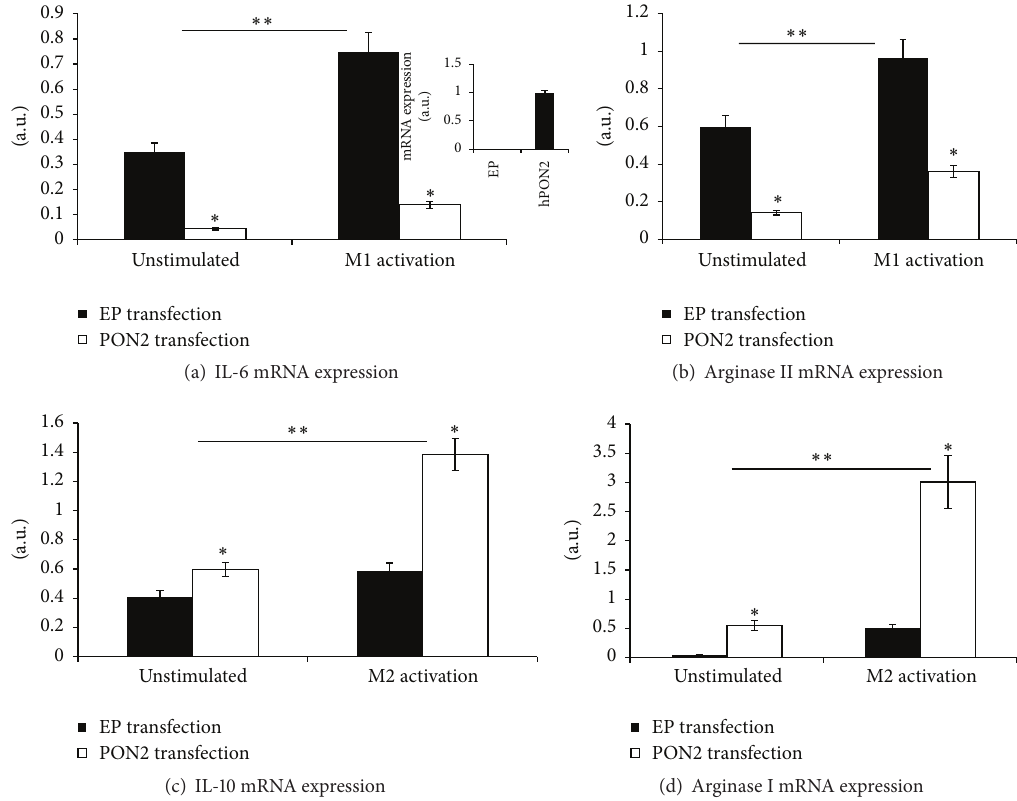
Figure 4: Direct effect of human PON2 (hPON2) on the inflammatory and anti-inflammatory responses in PON2KO MPM. MPM were harvested from 3-month-old PON2KO male mice. The cells were transfected with pcDNA3.1+ empty plasmid (EP) or with pcDNA3.1+ plasmid containing hPON2 for 4 hours at 37 ∘ C. Cells were then washed and cultured with DMEM medium + 10% fetal calf serum for 48 hours. The cells were cultured for additional 12 hours unstimulated and then either M1-activated with IFN 𝛾 /LPS or M2-activated with IL-4. IL-6 (a), arginase ΙΙ (b), IL-10 (c), and arginase Ι (d) mRNA expressions were determined by quantitative PCR and results were normalized to GAPDH expression. The inset of (a) shows hPON2 mRNA expression in PON2-deficient MPM transfected with EP and PON2KO MPM transfected with hPON2. Results are expressed as mean ± SD ( 𝑛 = 3 ), ∗ 𝑃 < 0.01 , PON2KO MPM versus control MPM; M1 stimulated versus unstimulated, ∗∗ 𝑃 < 0.001 , M1, M2 stimulated versus unstimulated